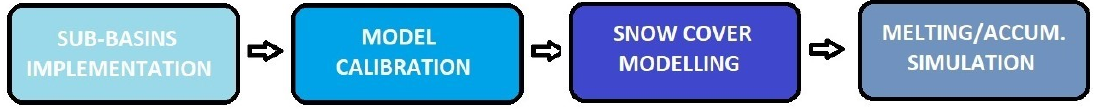
Figure 1. Methodological scheme applied to the Tagus Basin.